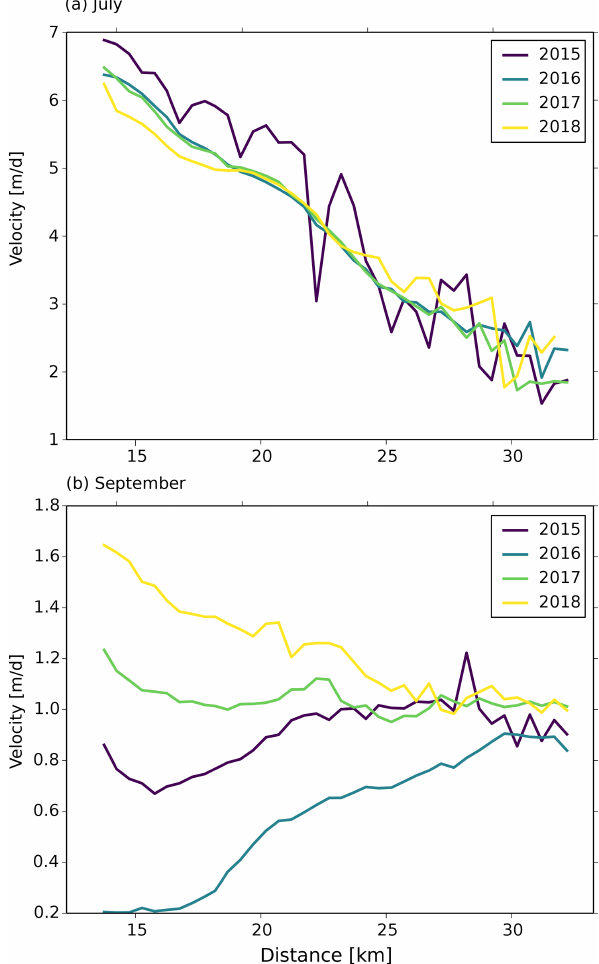
Figure 9. Longitudinal velocity profiles for always a month with high velocities (July) (a) and a month with low velocities (Septem- ber) (b) . The distance is measured from the 1916 glacier front posi-